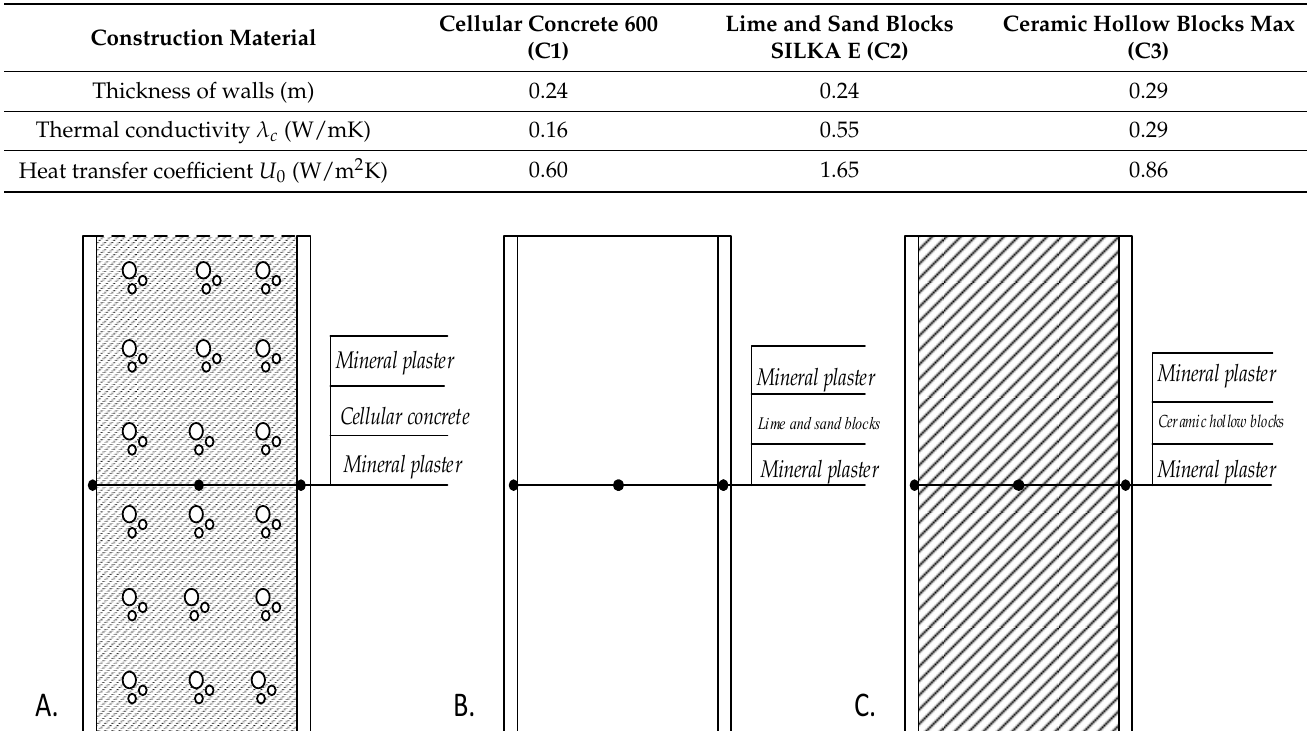
Figure 1. Cross-sections of the analyzed partitions made of: ( A ) cellular concrete; ( B ) lime and sand blocks; ( C ) ceramic hollow blocks.